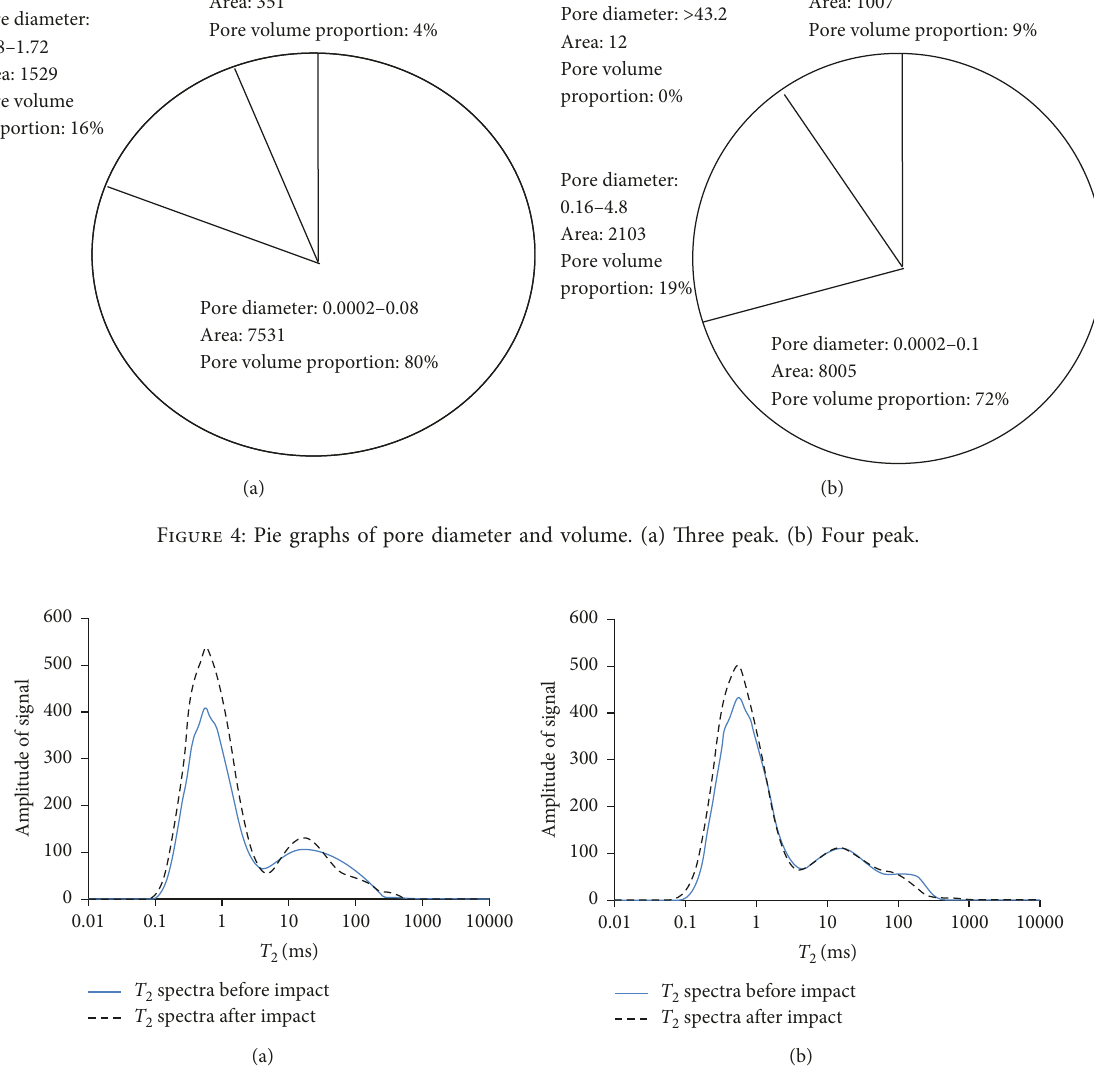
Figure 5: Comparison of T 2 spectra of sandstone samples before and after SHPB experiment. (a) 92# dry sandstone. (b) 64# saturated sandstone.